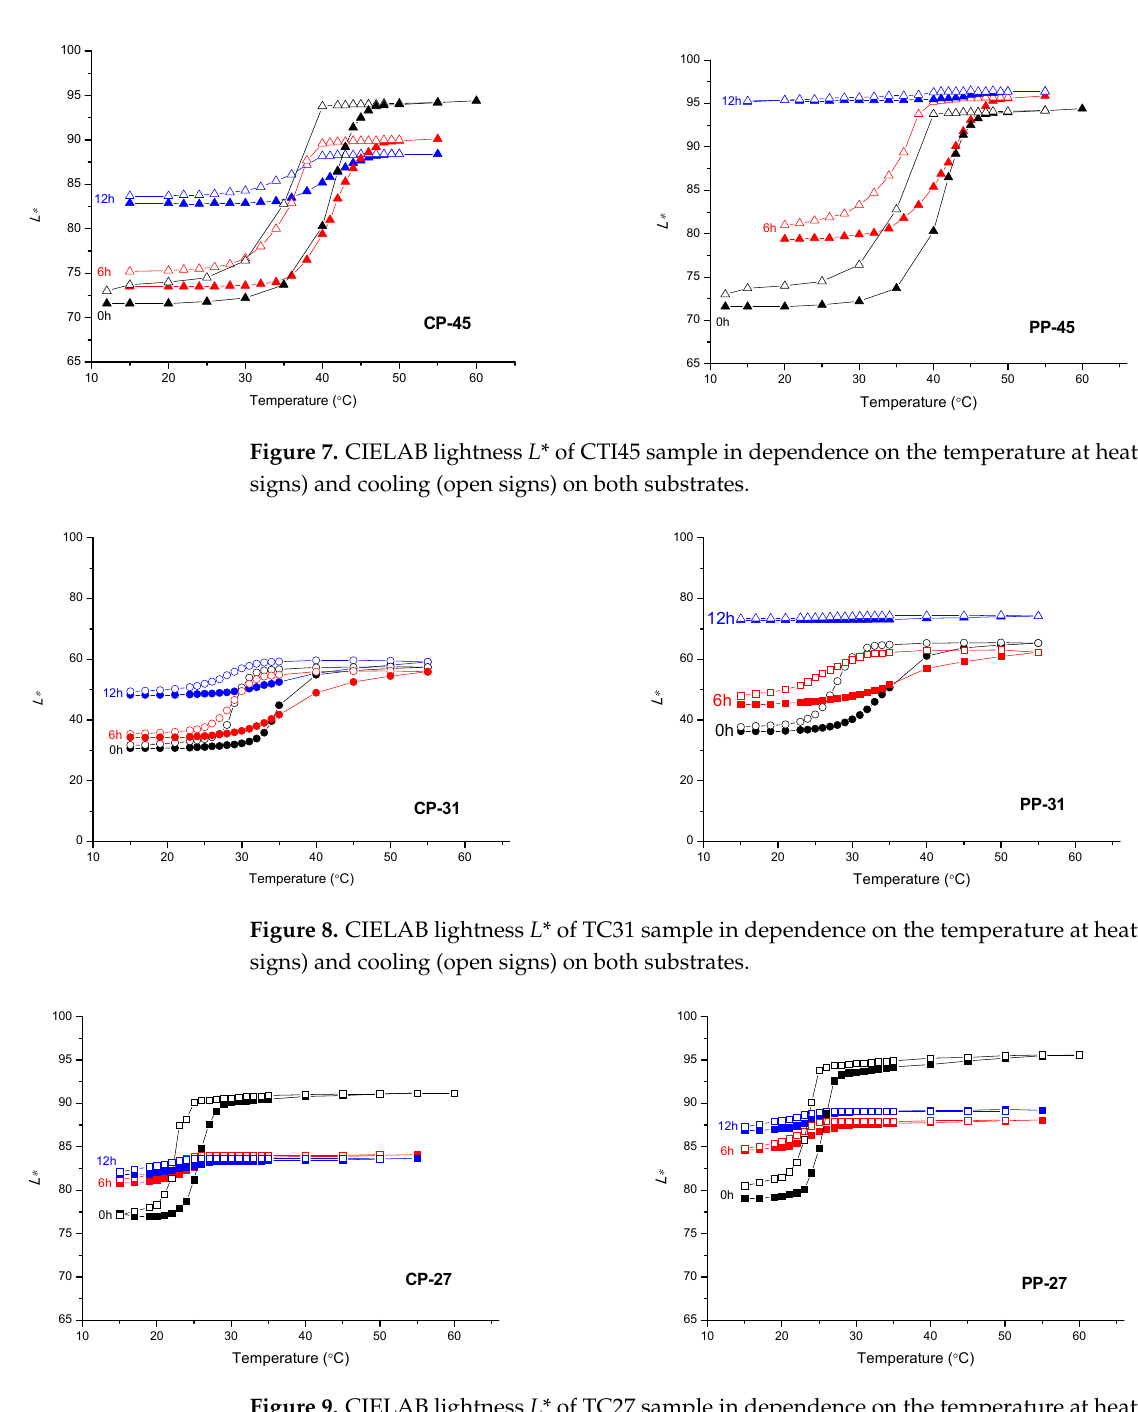
Figure 9. CIELAB lightness L * of TC27 sample in dependence on the temperature at heating (solid signs) and cooling (open signs) on both printing